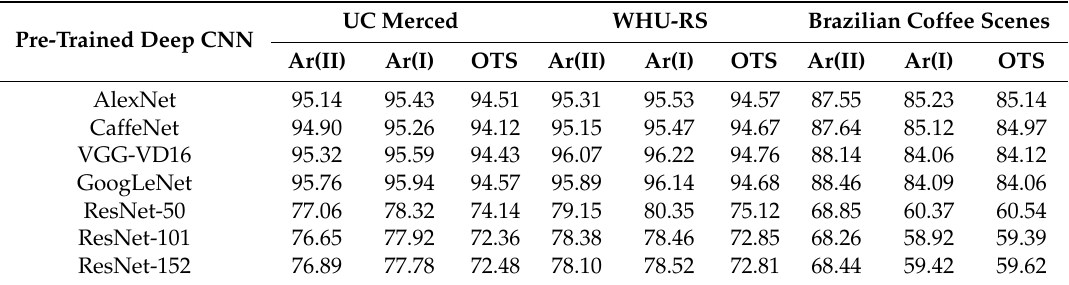
Table 5. Classification accuracy (%) of Architecture (II), Architecture (I) and Off-the-shelf on different remote sensing datasets.